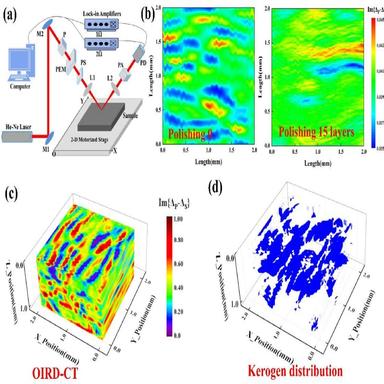
OIRD-CT images of the oil shale and its flocculent kerogen. (a) The principle of OIRD imaging. (b) The OIRD image of polished oil shale layers 0 and 15. (c) The OIRD-CT image of the oil shale. (d) The OIRD-CT image of the kerogen in the oil shale.